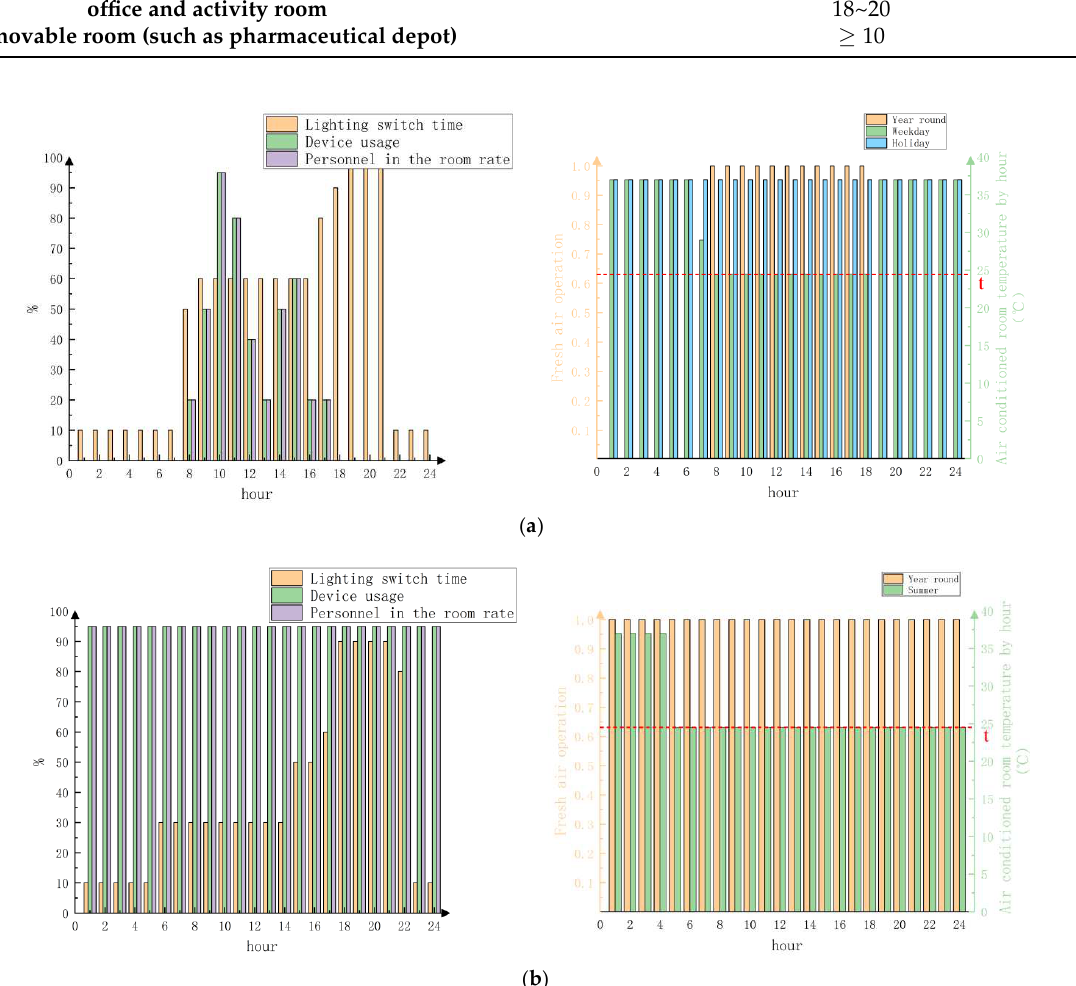
Figure 14. The operating parameters of the air conditioning system in the outpatient department ( a ) and inpatient department ( b ) were calculated by simulation. Table 19. Room partitioning parameters for healthcare buildings.